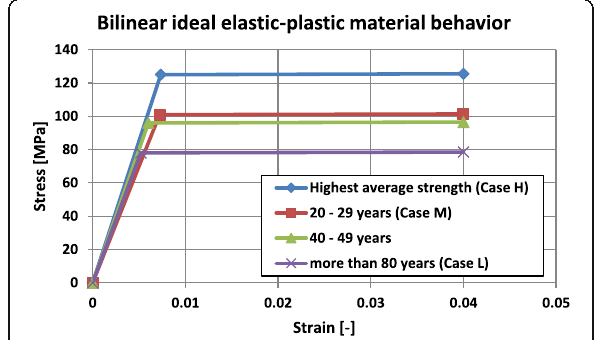
PLL: The highest average strength curve (case H) was based on the mean values of the Table